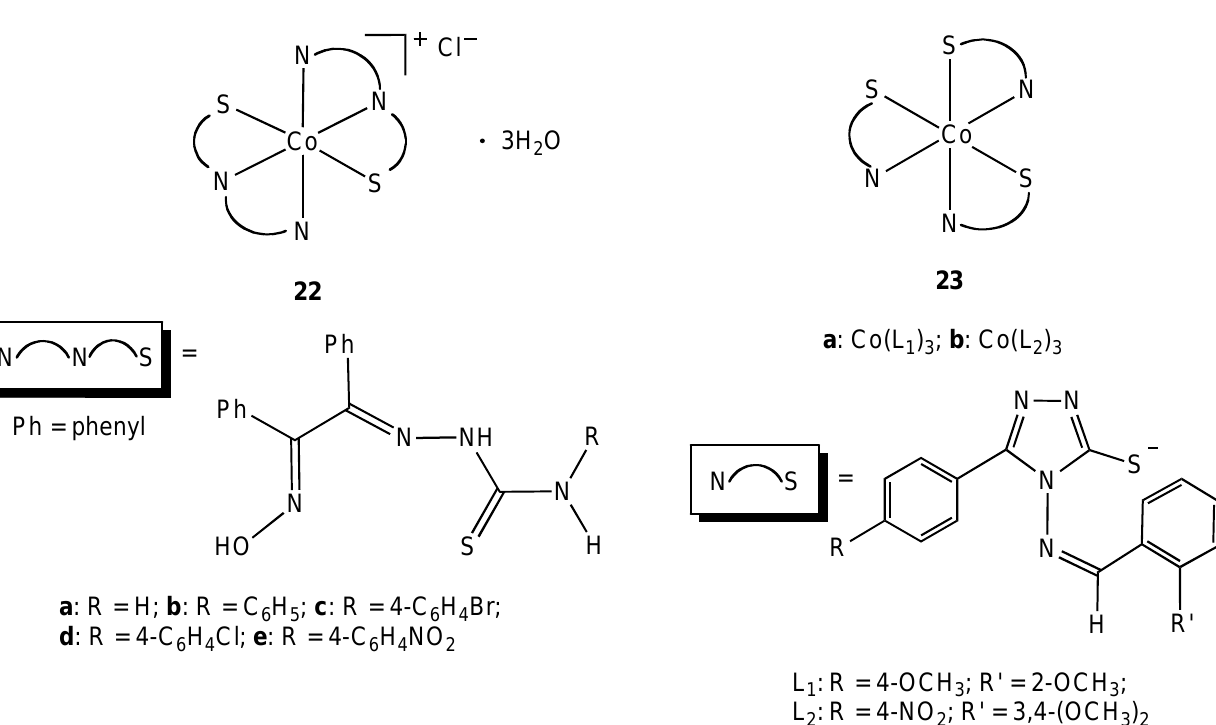
Figure 13. Cobalt(III) complexes containing bidentate and tridentate nitrogen/sulfur donor